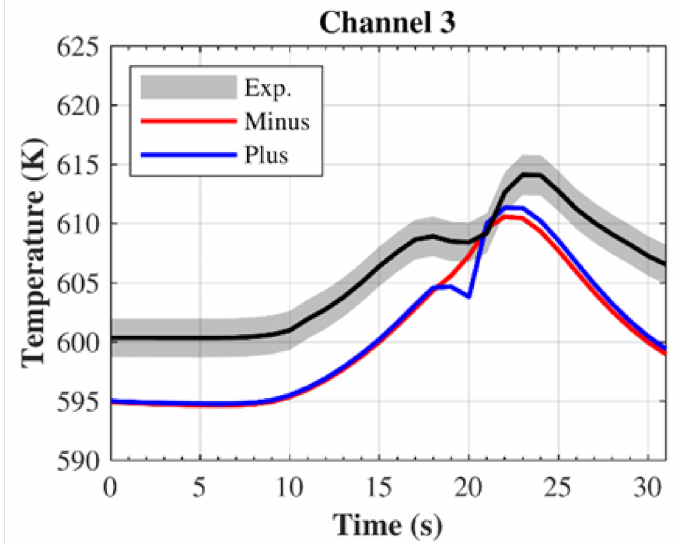
Figure 13. Outlet coolant temperature—300 kW/m 2 , 0% valve opening scenario. Comparison of the two runs adopting the coolant inlet pressure in Channel 1 as parameter for the best-estimate